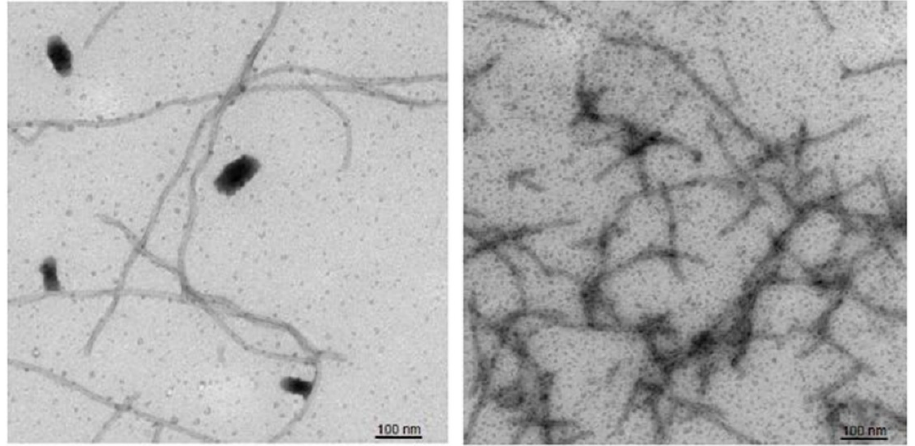
Figure 4. Fibrils of recombinant ( left ) and synthetic ( right ) A β 42. Negative stain EM analysis. The figure is reprinted from [23].